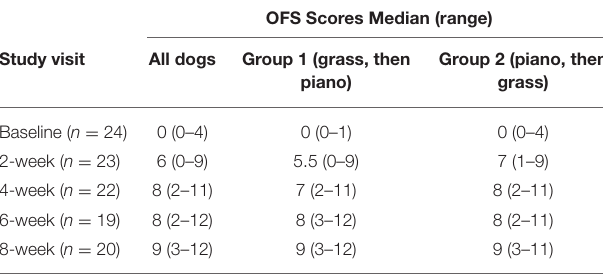
TABLE 1 | OFS scores at each study visit. OFS Scores Median